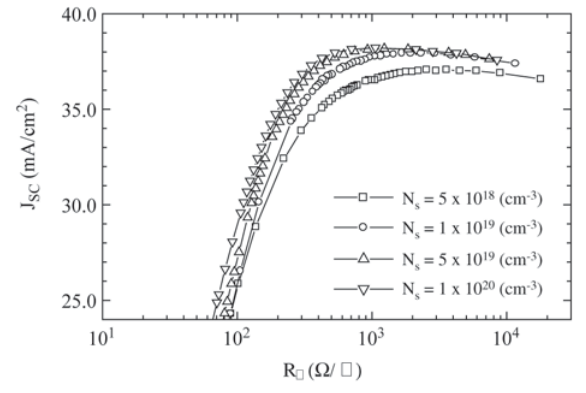
as function of emitter sc , considering p- s